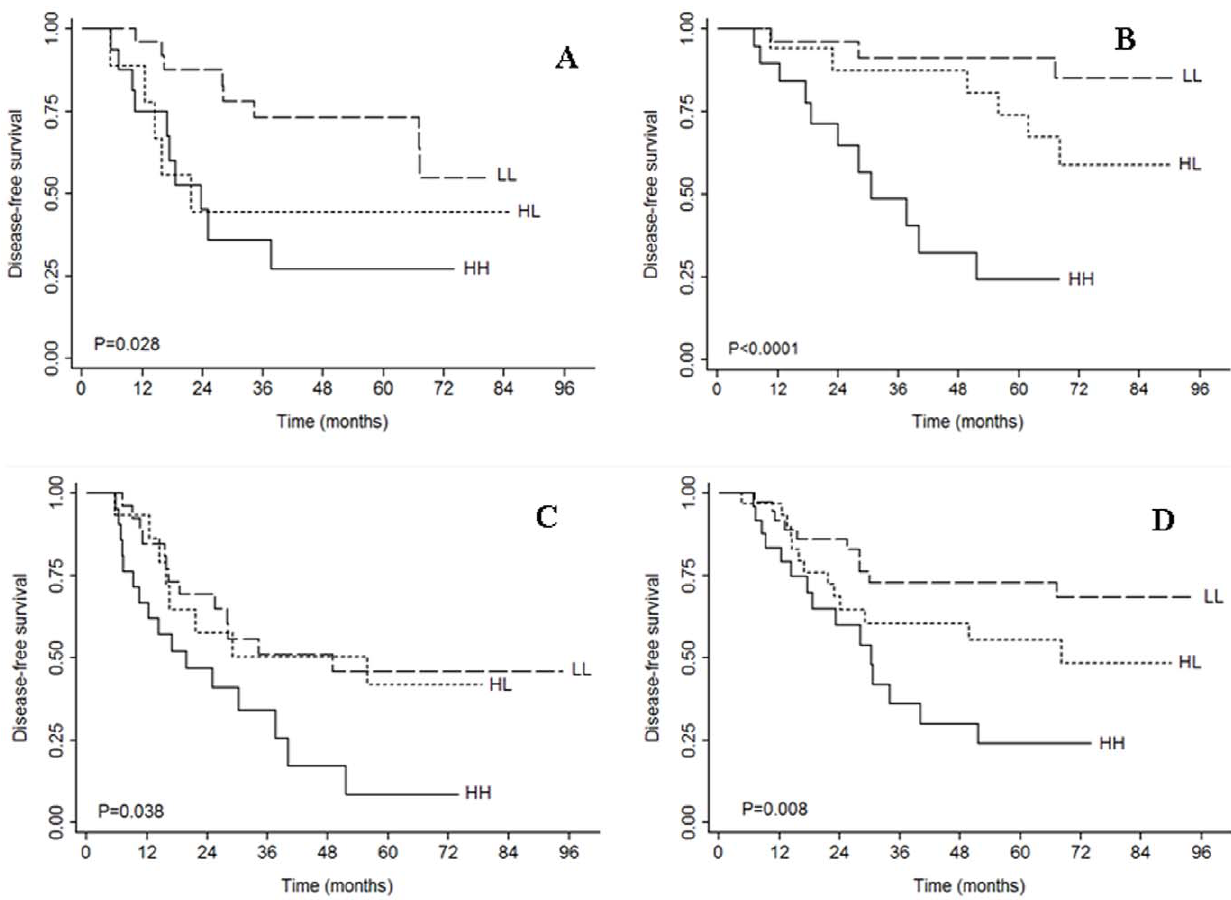
Figure 3. Kaplan-Meier plots of DFS according to the expression of CD31 and nucleolin in the subgroups: (A) Squamous cell carcinoma (SCC) and adenosquamous cell carcinoma (ADSCC), (B) Tumor size , 5 cm, (C) Stage I, and (D) Surgery alone. HH: CD31hiNCLhi, HL: CD31hiNCLlo, and LL: CD31loNCLlo.